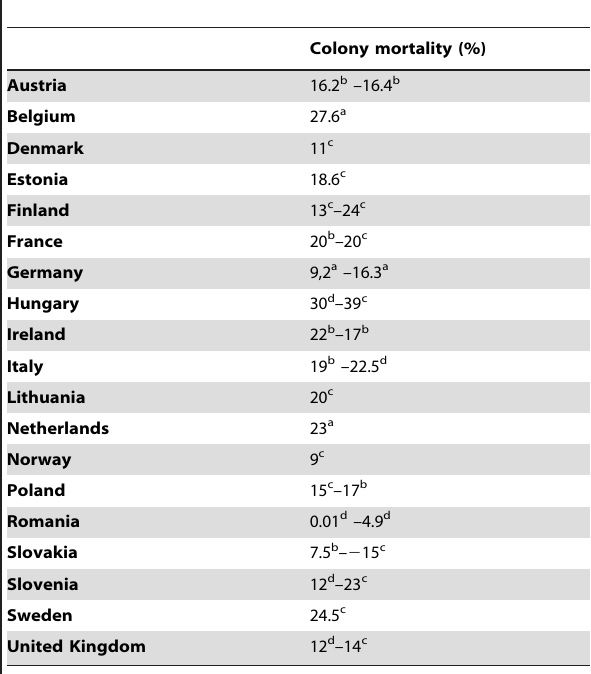
Table 7. Mortality of honeybee colonies in Europe in 2010, percentage and origin of the